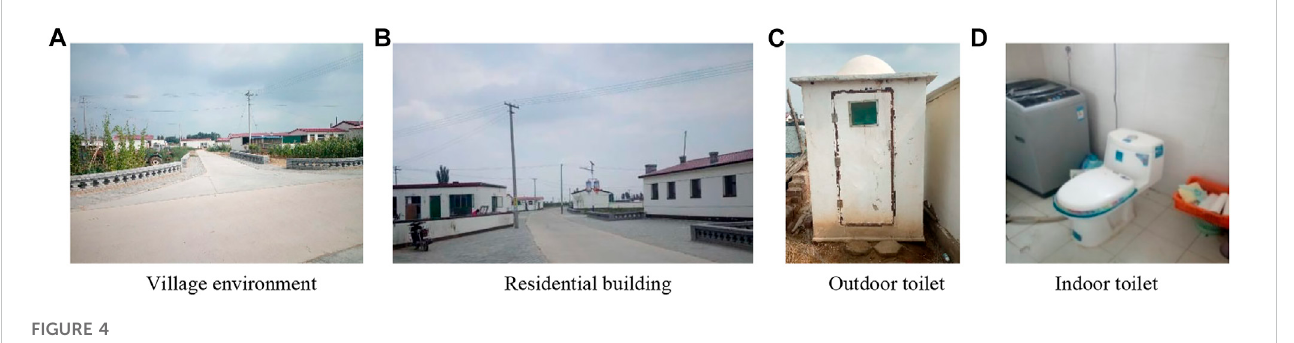
FIGURE 4 Village, building and toilets.